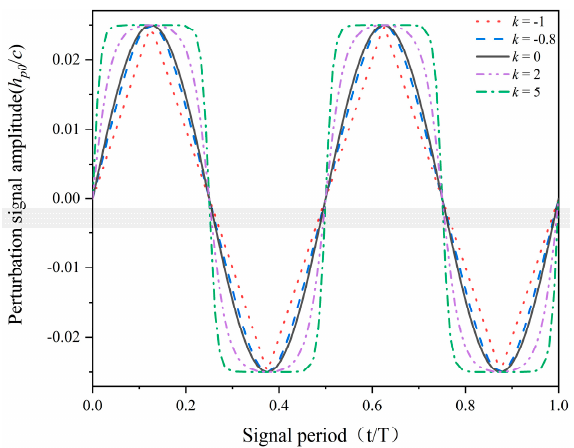
Figure 2. Variation of the perturbation signal waveform in one period at different k.